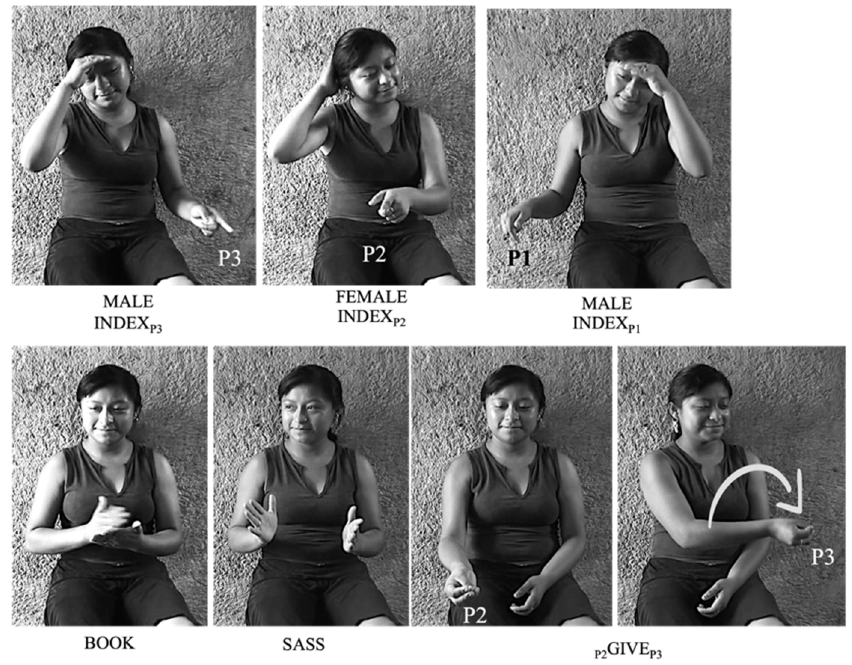
Figure 7. Second generation signer from Chicán using double agreement “There is a man here, a woman here, (and) a man here, the woman (P2) gives the book to the man (P3)”.